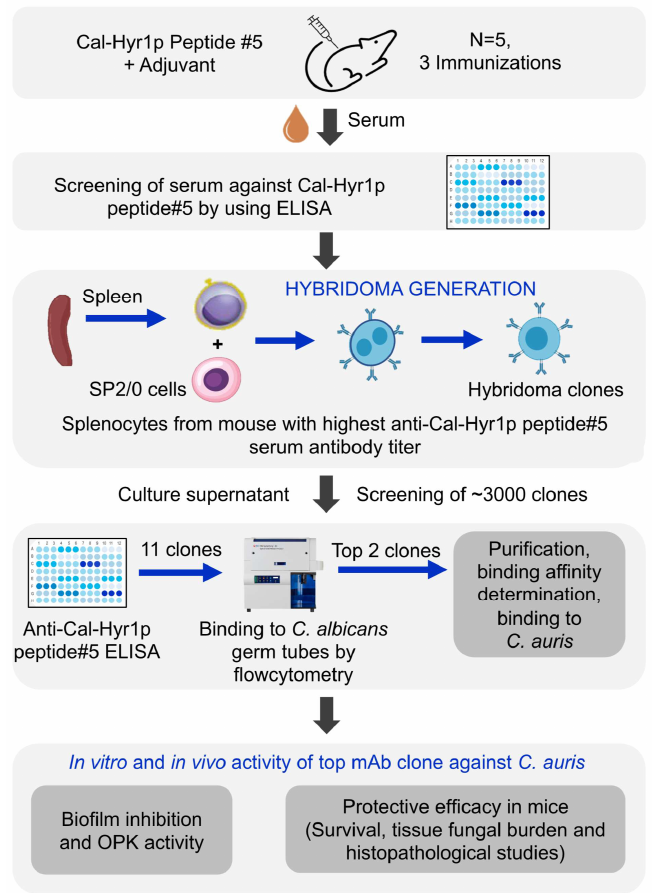
Figure 1. Overview of the Anti-Cal-Hyr1p peptide#5 MAb development and their in vitro and in vivo testing.